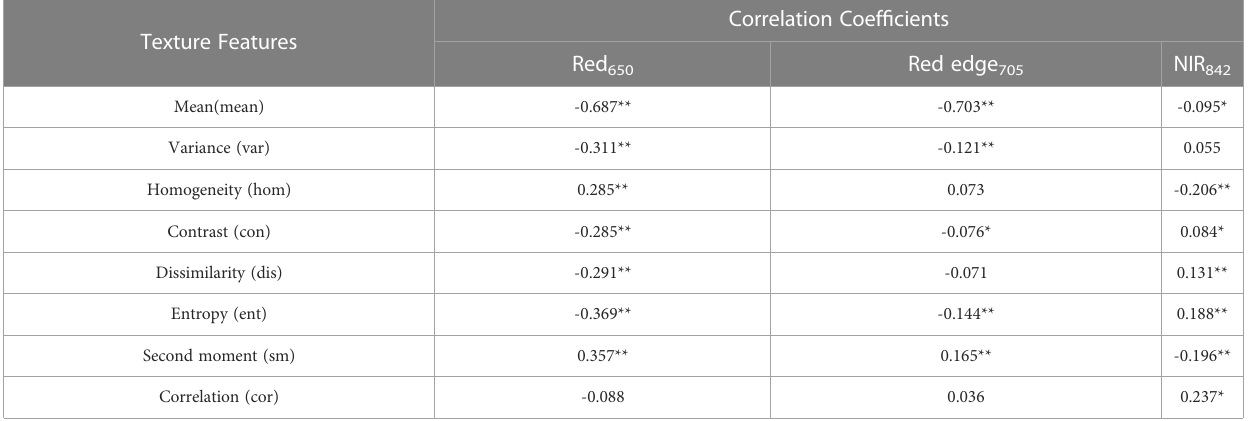
TABLE 3 Correlation coef fi cients between texture features of the three bands and LAI.